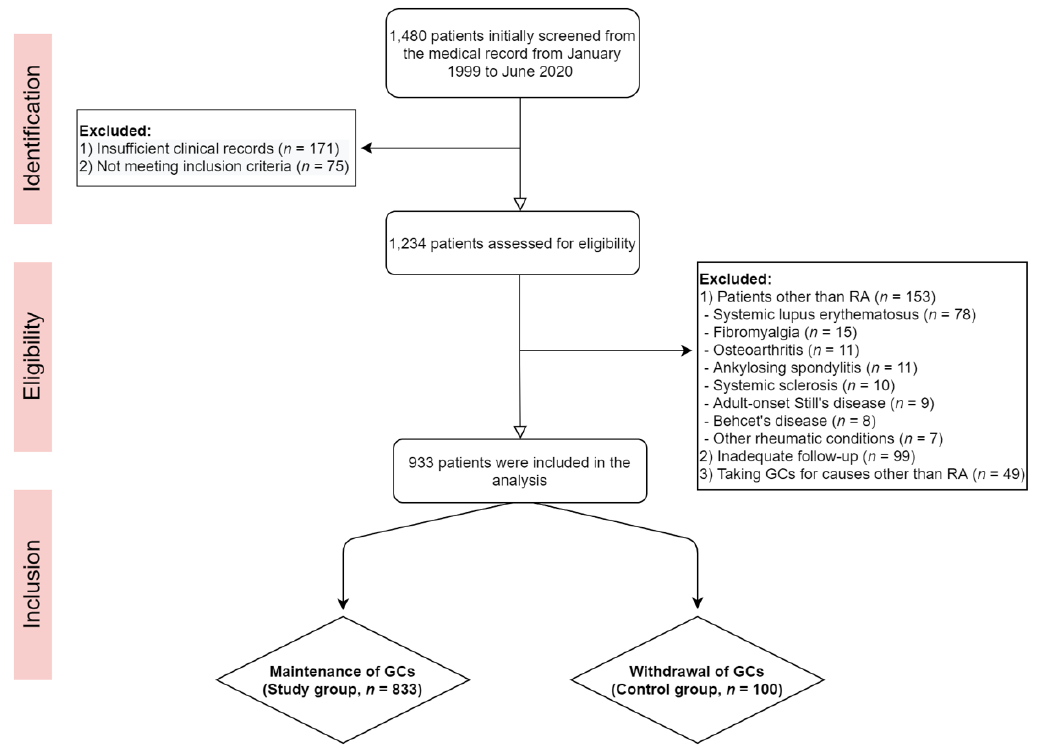
Figure 1. Flowchart of this retrospective study. RA: Rheumatoid arthritis, GCs: Glucocorticoids.